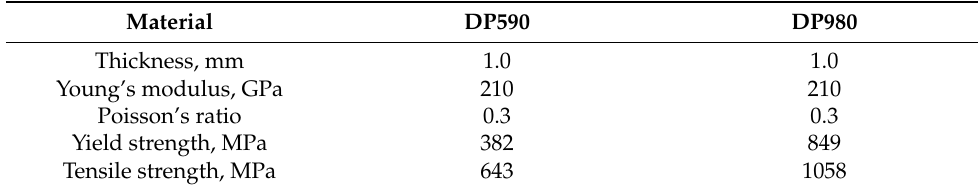
Table 2. Mechanical properties of the sheet